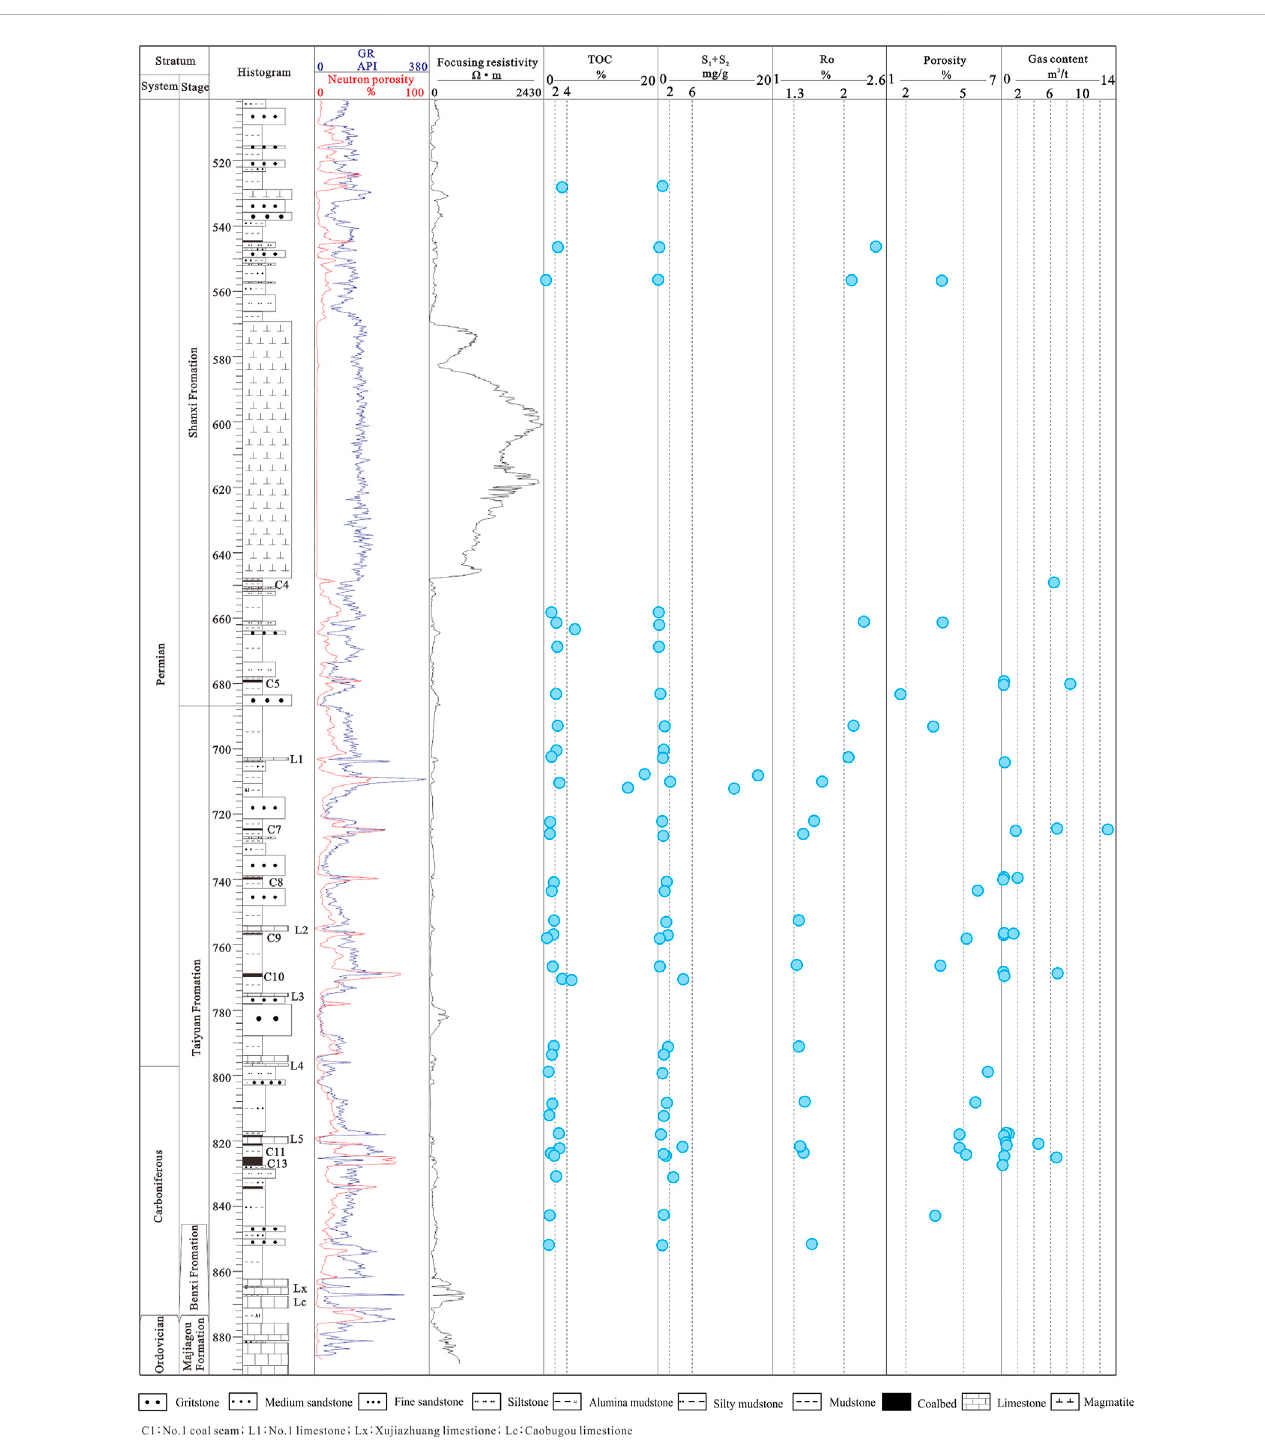
FIGURE 4 Geochemical and physical characteristics of the coal-measure source rock in Well